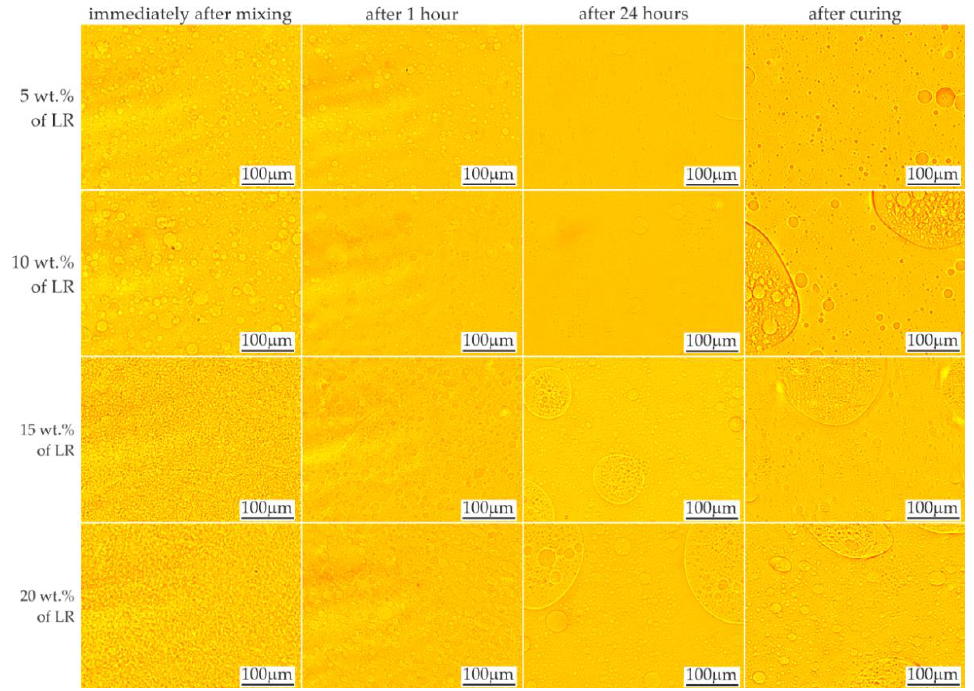
Figure 3. LOM images showing time stability of resin F mixed with liquid rubber.